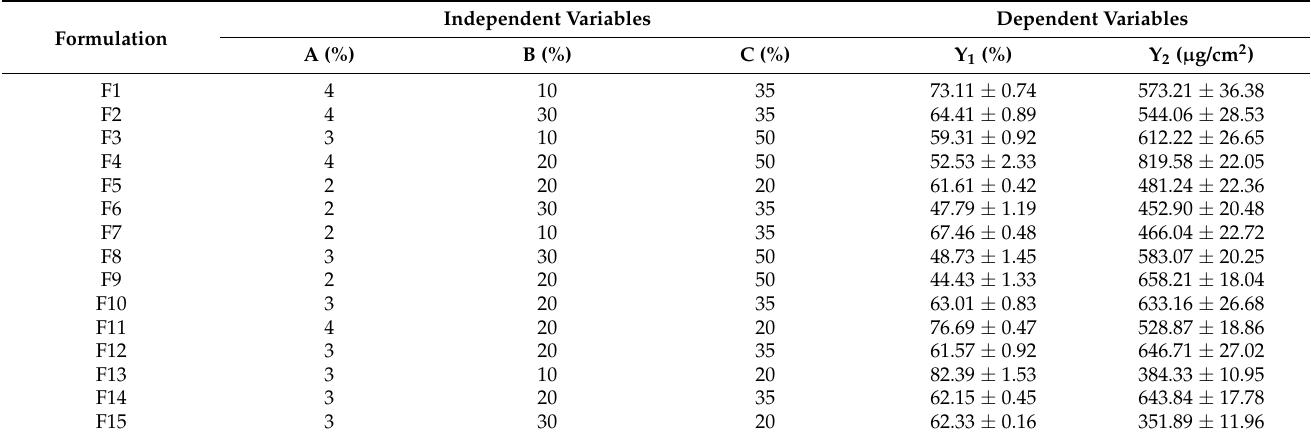
Table 1. The values of independent factors utilized for optimization of transethosomal preparations and the determined outcomes of dependent